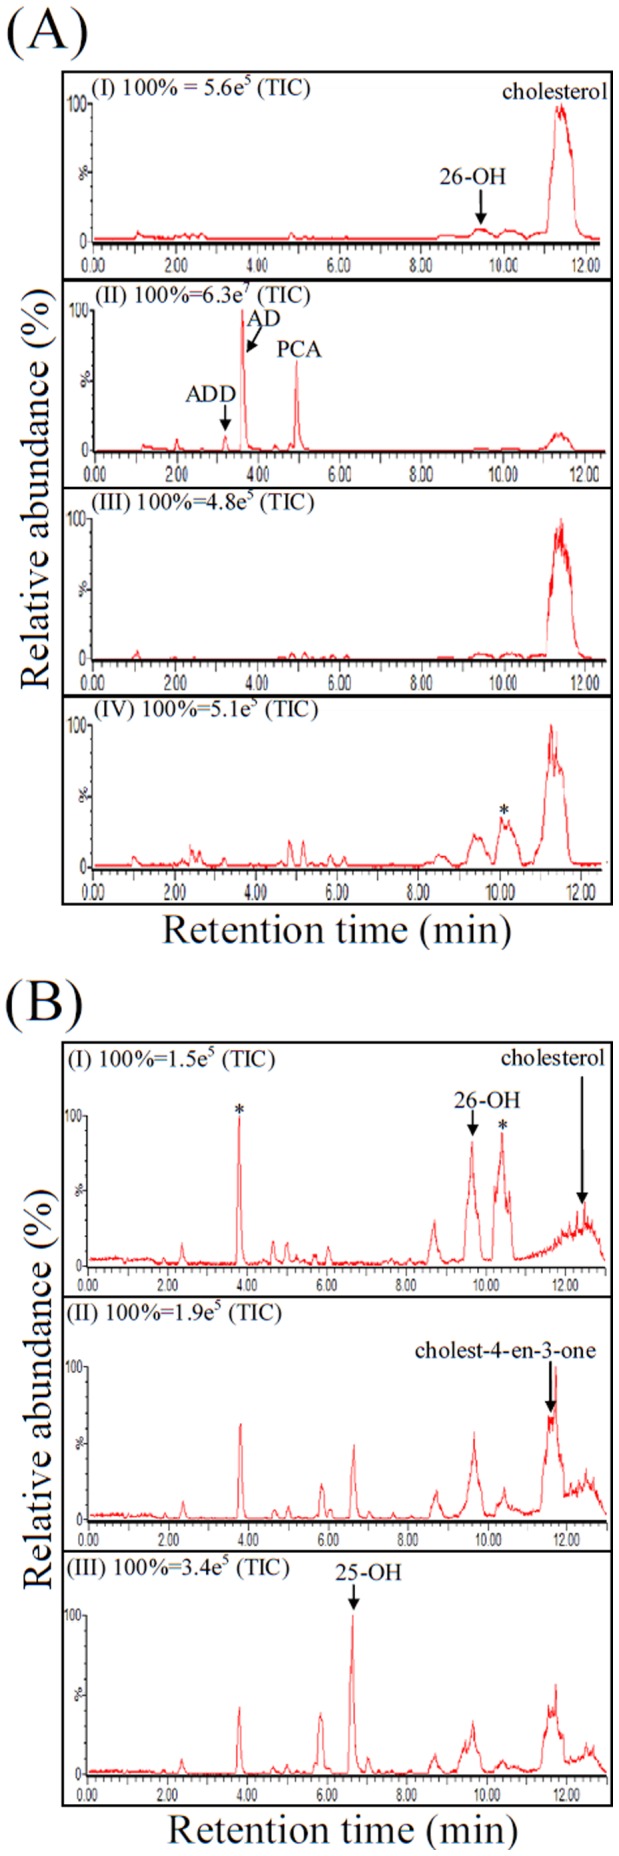
Aerobic cholesterol catabolic pathway byS denitrificans was inhibited by tert-butyl alcohol but not by α,α′-D.(A) UPLC-HRMS analysis of ethyl-acetate extracts of cholesterol-grown bacterial cells with or without α,α′-D. (AI) G. cholesterolivorans DSMZ 45229 grown with cholesterol (2 mM), (AII) G. cholesterolivorans grown with cholesterol and α,α′-D (5 mM), (AIII) S. denitrificans DSMZ 13999 grown with cholesterol, and (AIV) S. denitrificans grown with cholesterol and α,α′-D. (B) UPLC-HRMS analysis of ethyl-acetate extracts of cholesterol-grown S. denitrificans cells with different concentrations of tert-butyl alcohol. (BI) The aerobic growth without tert-butyl alcohol, (BII) in the presence of 2.5% (v/v) tert-butyl alcohol, and (BIII) in the presence of 5% tert-butyl alcohol. Abbreviations: TIC, total ion current; 26-OH, 26-hydroxycholest-4-en-3-one; 25-OH, 25-hydroxycholest-4-en-3-one; PCA, pregn-4-en-3-one-20-carboxylic acid; AD, androst-4-en-3,17-dione; ADD, androsta-1,4-diene-3,17-dione; *, unidentified nitrogen compounds.